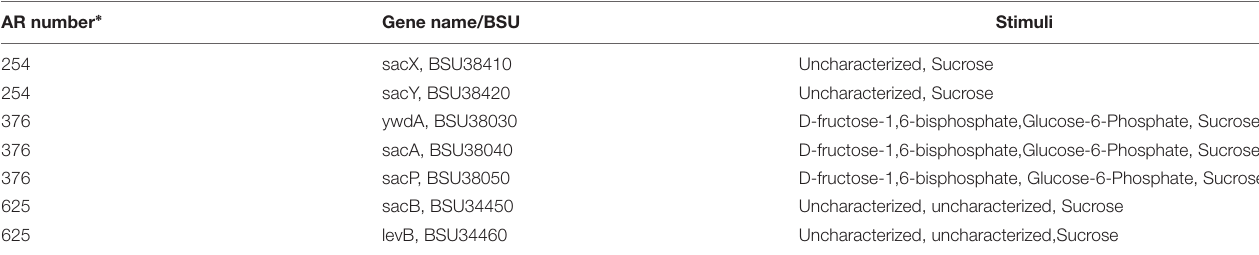
TABLE 2 | Sucrose stimulon represented in the Atomic Regulon (AR) web analysis